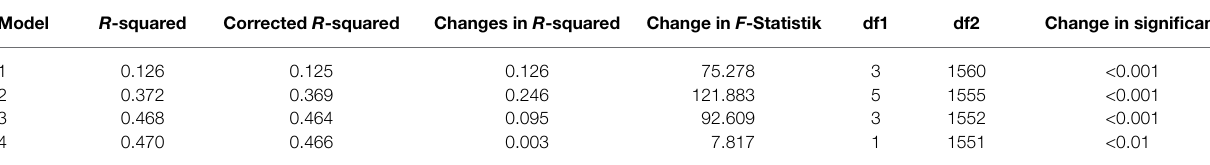
TABLE 7 | ANOVA regression table. Model R -squared Corrected R -squared